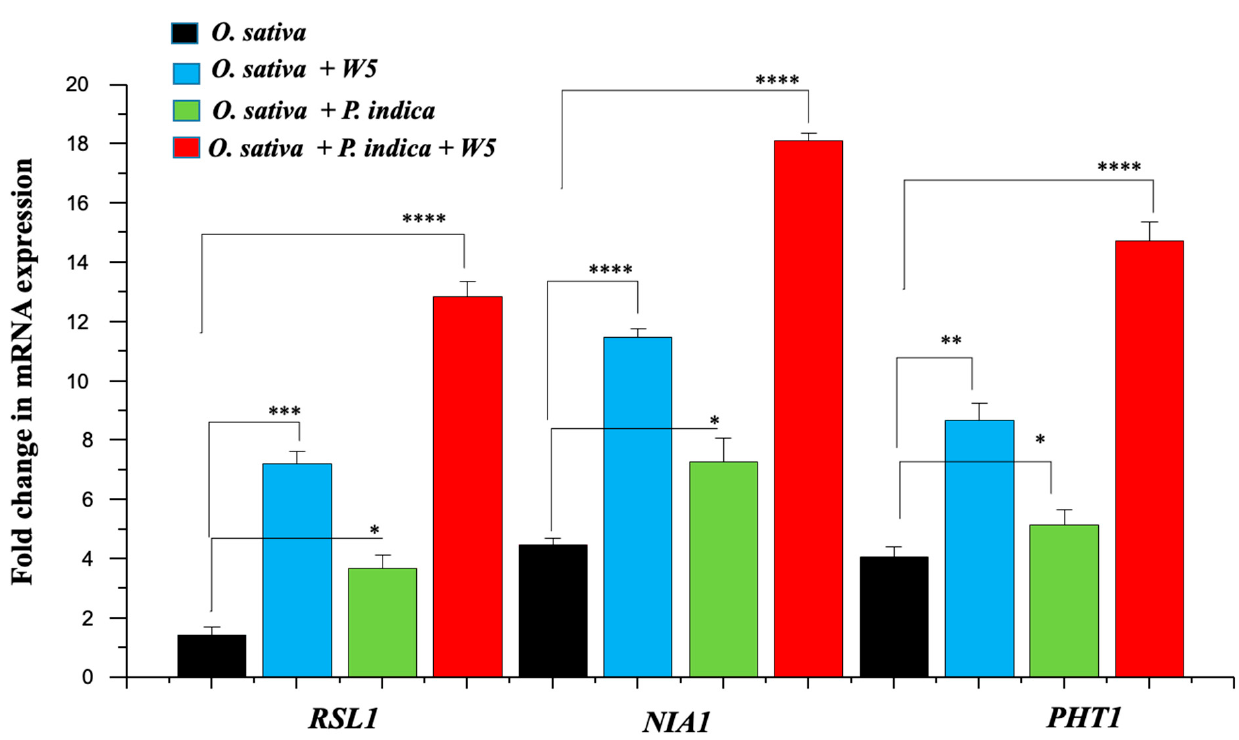
Figure 3. Changes in the expression of selected O. sativa genes RSL1, NIA1, and PHT1 observed 96 HPI with P. indica and W5 individually or in co-inoculation. Values represented as mean ± se. ( n = 3, p -value * ≤ 0.05, ** ≤ 0.01, *** ≤ 0.001 and **** ≤ 0.0001) compared with control (P. indica ). Standard error (SE) is represented by error bars.